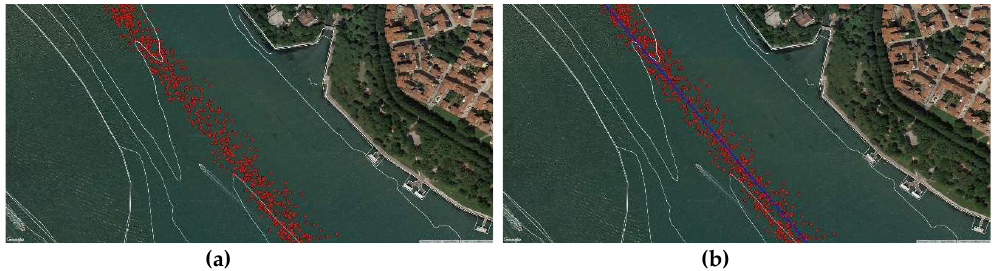
Figure 10. ( a ) Close-up of the AIS position data of ships over 50.000 tons in the Lagoon; ( b ) Resulting statistical followed route.